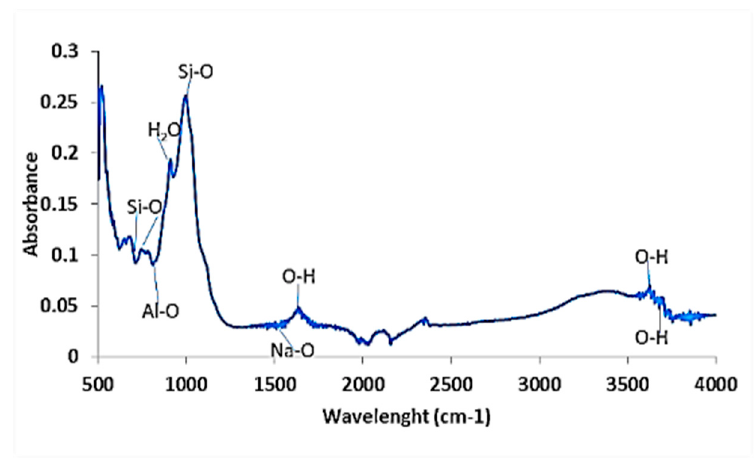
Figure 4. FT-IR Spectra of the activated clay sample.